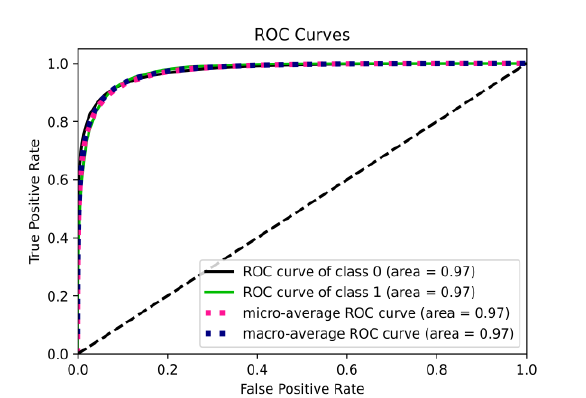
Figure 3. The ROC curve obtained from Model-A.